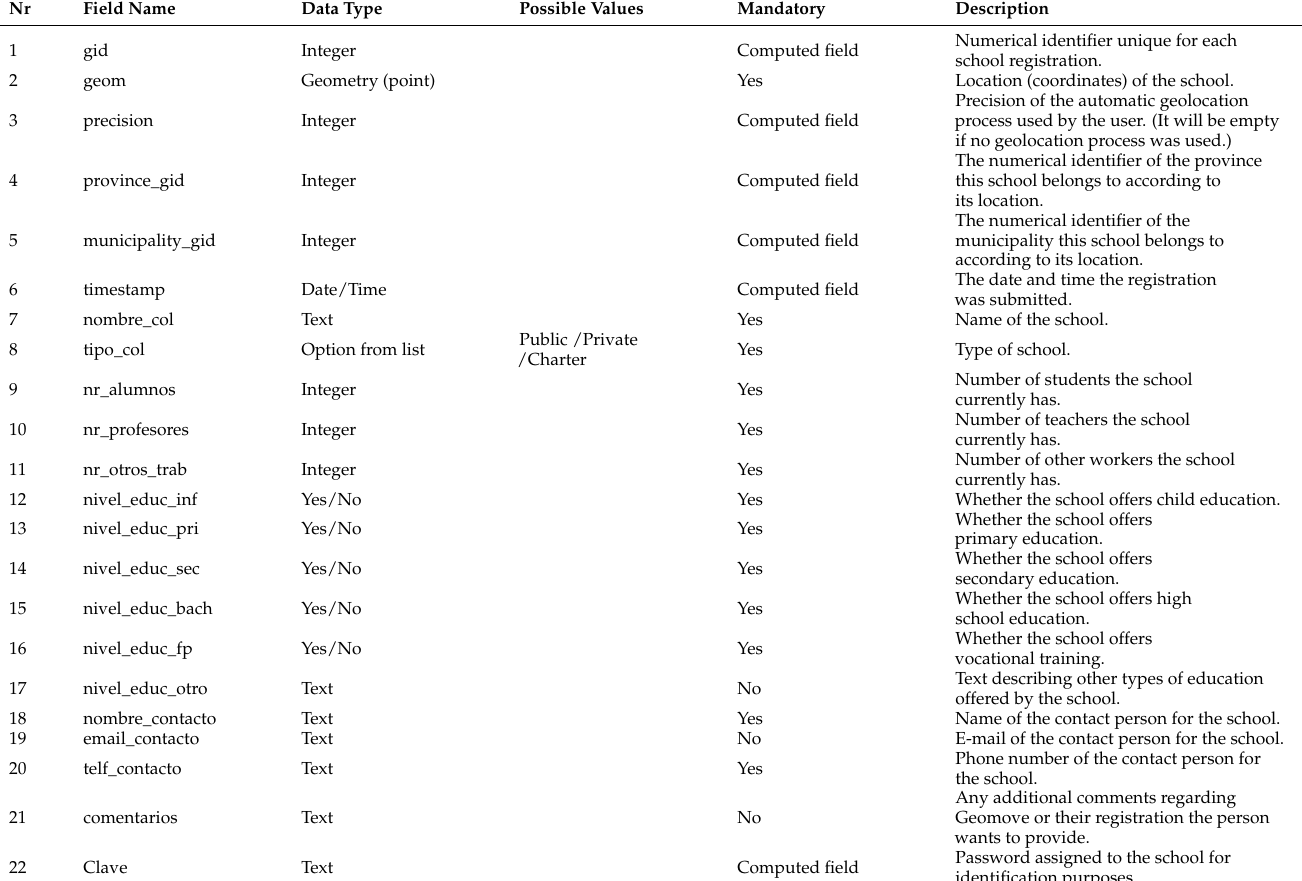
Table A1. Structure of Geomove database. Schools registration